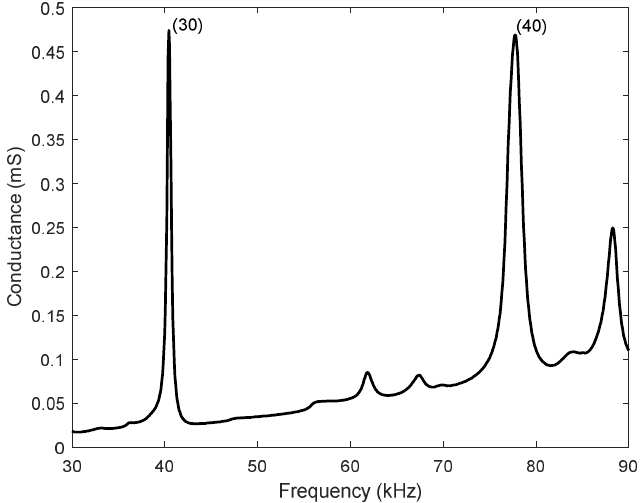
Figure 5. Electrical conductance vs. frequency of a structure designed for the low-order modes combination.